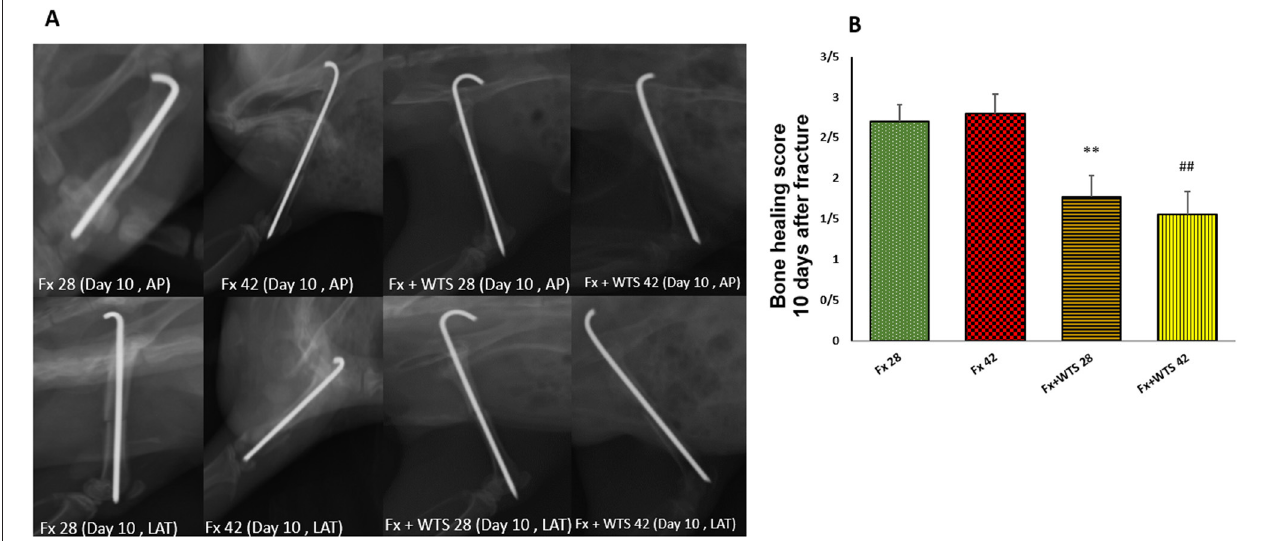
FIGURE 4 | Radiographic evaluation revealed WTS decreased the process of fracture healing 10 days after fracture. (A) X-ray images of lateral and AP view of the femur. (B) The score of bone healing in experimental groups. Fx 28: group subjected to room air for 28 days after surgery and a femoral bone fracture, Fx 42: group subjected to room air for 42 days after surgery and a femoral bone fracture, Fx + WTS 28: group subjected to WTS for 28 days after surgery and a femoral bone fracture, Fx + WTS 42: group subjected to WTS for 42 days after surgery and a femoral bone fracture. The results are presented as mean ± SE, n = 10. ** P < 0.01 vs. Fx 28; ## P < 0.01 vs. Fx 42.